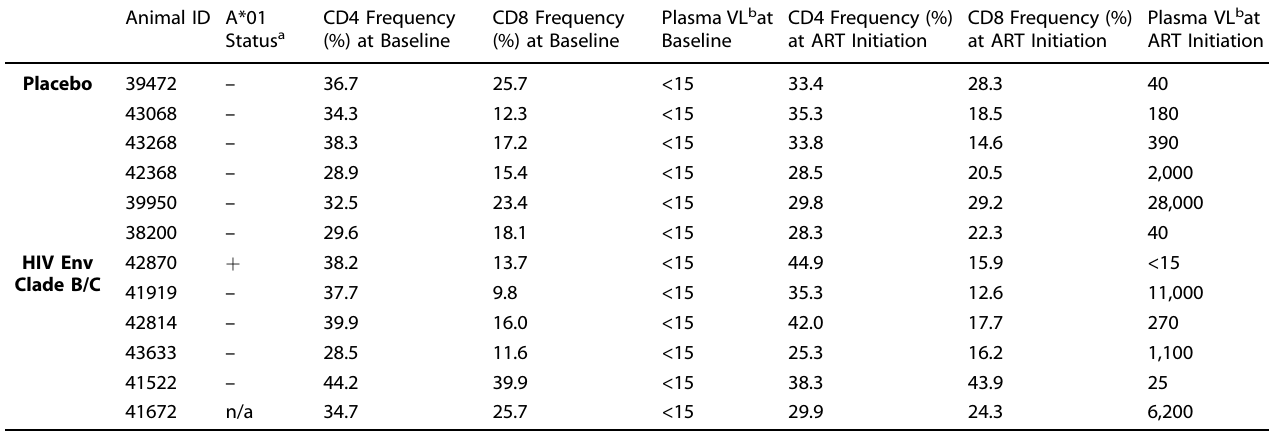
Table 1. MHC status, immune parameters and viral load at baseline and prior to ART initiation in vaccine and placebo recipient SHIV-infected, ART- treated RMs. Animal ID A*01 Status a